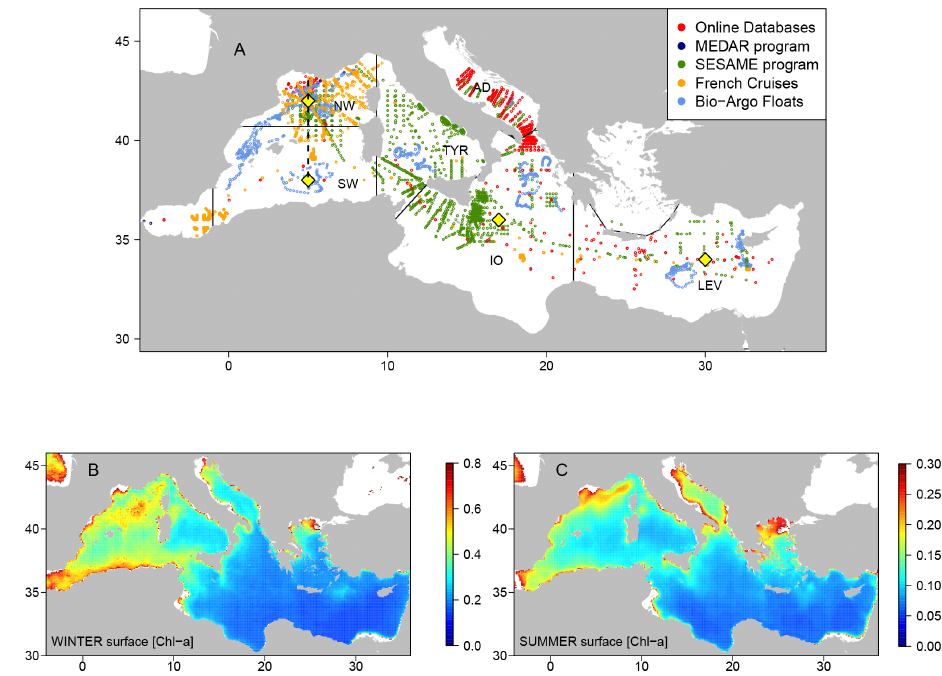
Figure 1. Panel (a) : spatial distribution of fluorescence profiles available in the database. Colors indicate the source of data. Black lines delineate large Mediterranean regions: they are referred to as NW for “northwest”, SW for “southwest”, TYR for “Tyrrhenian”, AD for “Adriatic”, IO for “Ionian” and LEV for “Levantine”. Yellow diamonds refer to the center of region for which a climatology of [Chl a ] vertical profile has been computed (see Fig. 3), and the dashed black line shows the center of the northwest transect (see Fig. 4). Panels (b) and (c) : SeaWiFS climatology of surface [Chl a ] for winter (b) and summer (c) . Note that color scales are not the